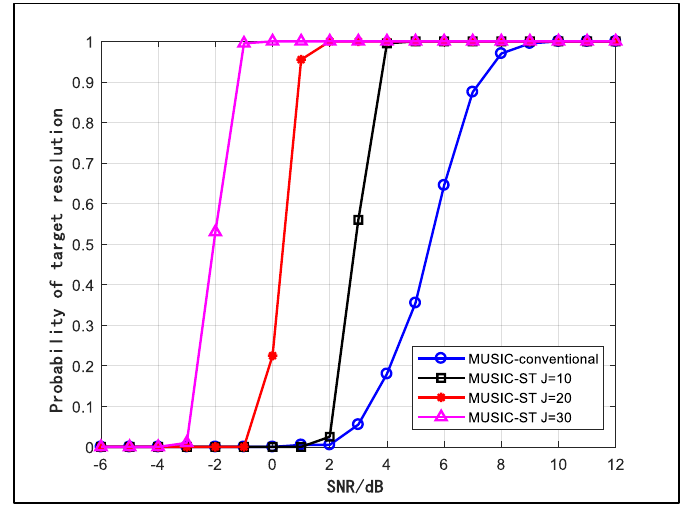
Figure 3. Probability of target resolution versus SNR. Figure 2. Probability of target resolution versus SNR. Figure 2. Probability of target resolution versus SNR.